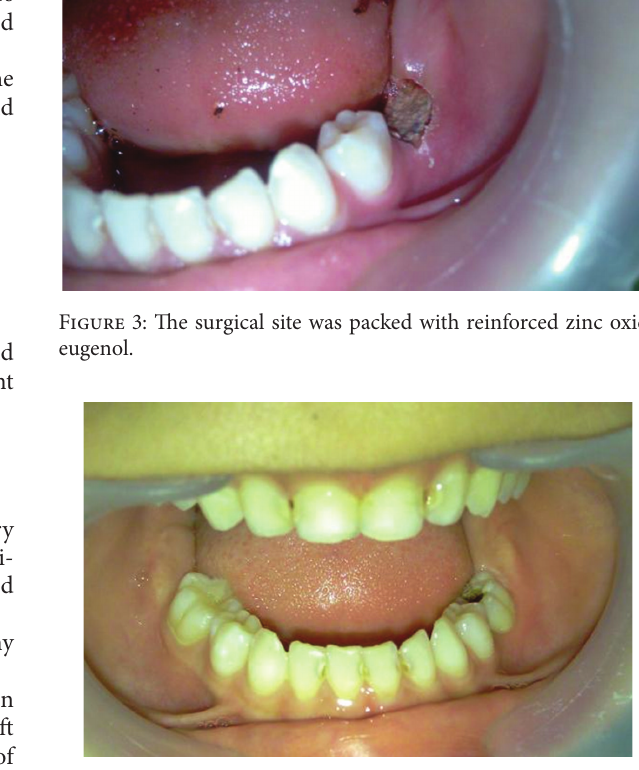
Figure 4: The tooth position four months after